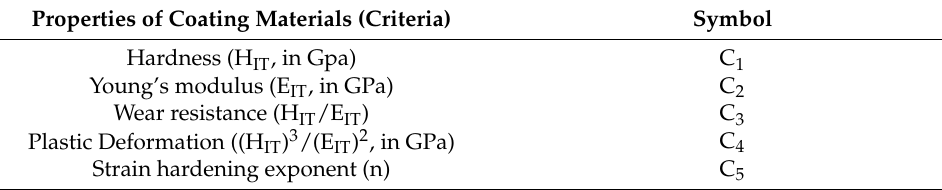
Table 10. Selection criteria of hard coating